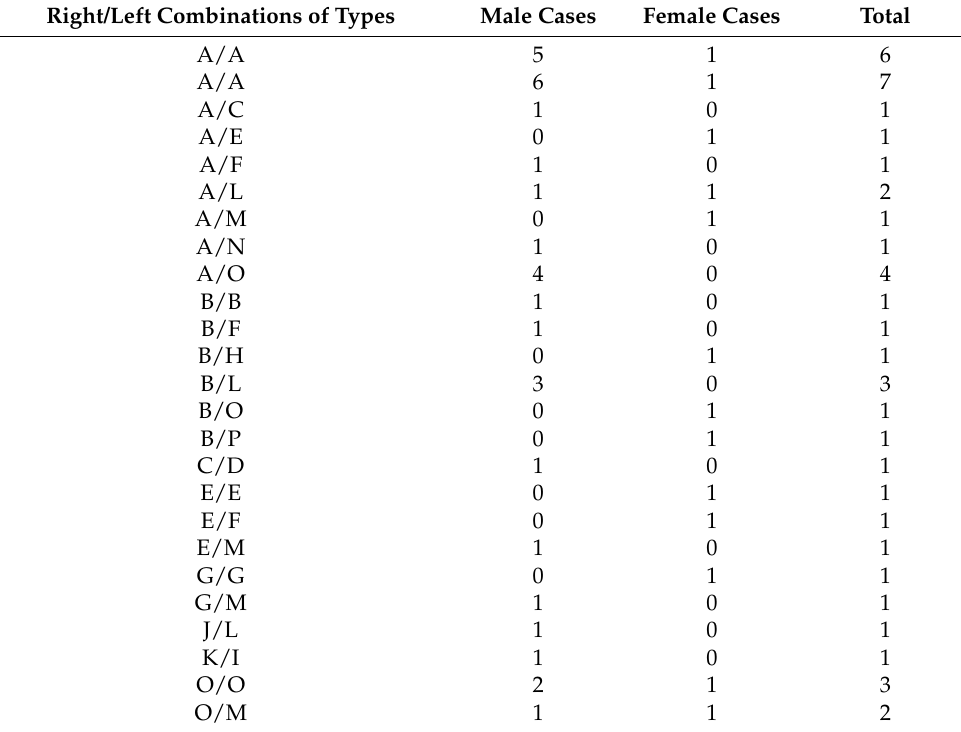
Table 3. Gender and lot distribution of bilateral combinations of pericallosal-callosomarginal types. Right/Left Combinations of